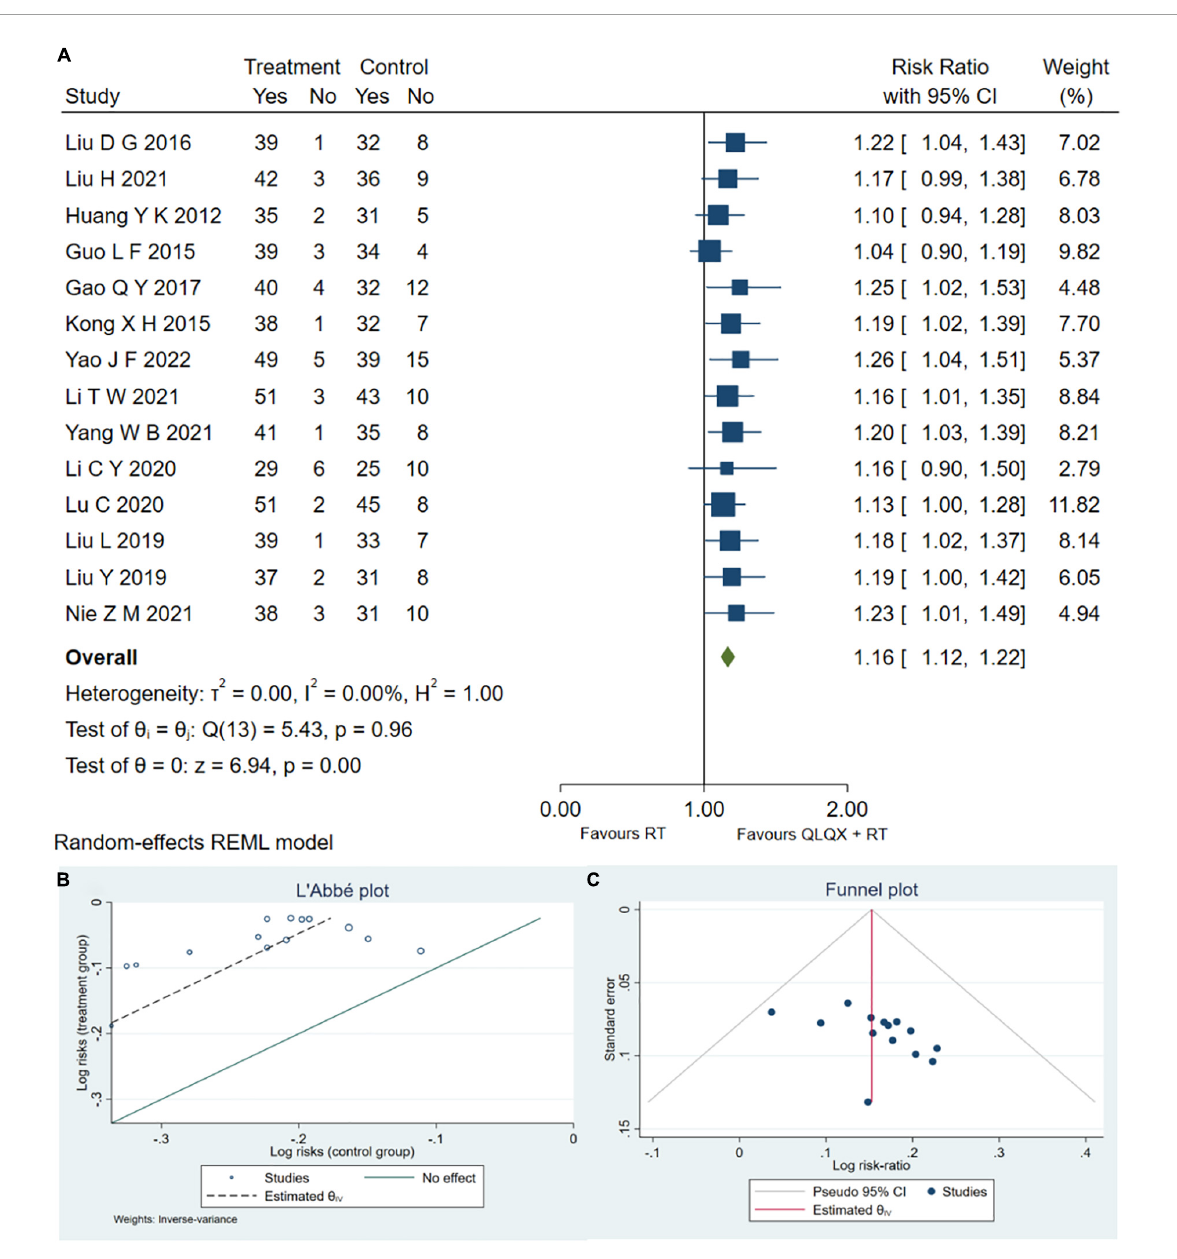
FIGURE3 (A) Forest plot of the clinical efficacy rate; (B) L’Abbe plot; (C) Funnel